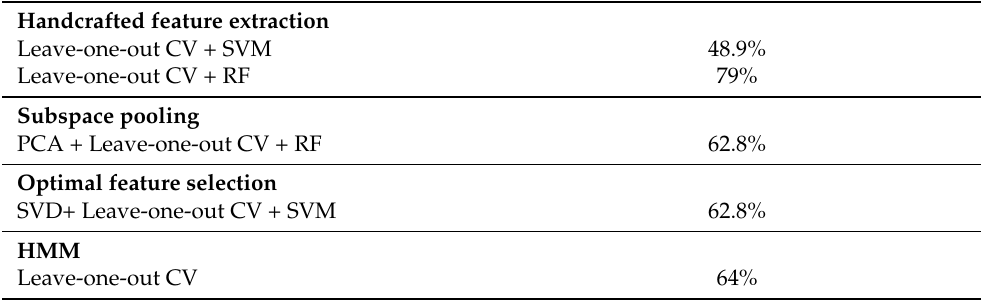
Table 6. The comparative analysis of all the feature extraction techniques along with the classifica- tion algorithms. In all the experiments of leave-one-out cross-validation, the average recognition accuracies are reported here.